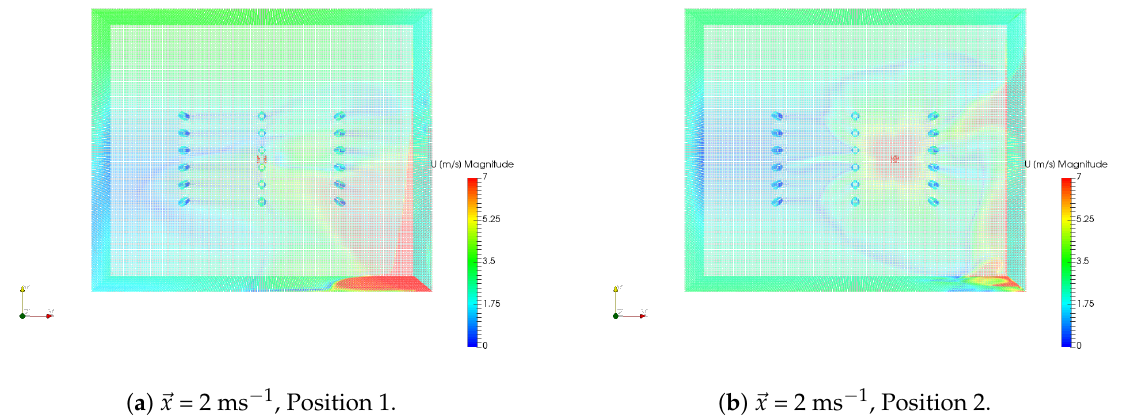
Figure 10. Drone wind flow simulations used as input for GADEN.